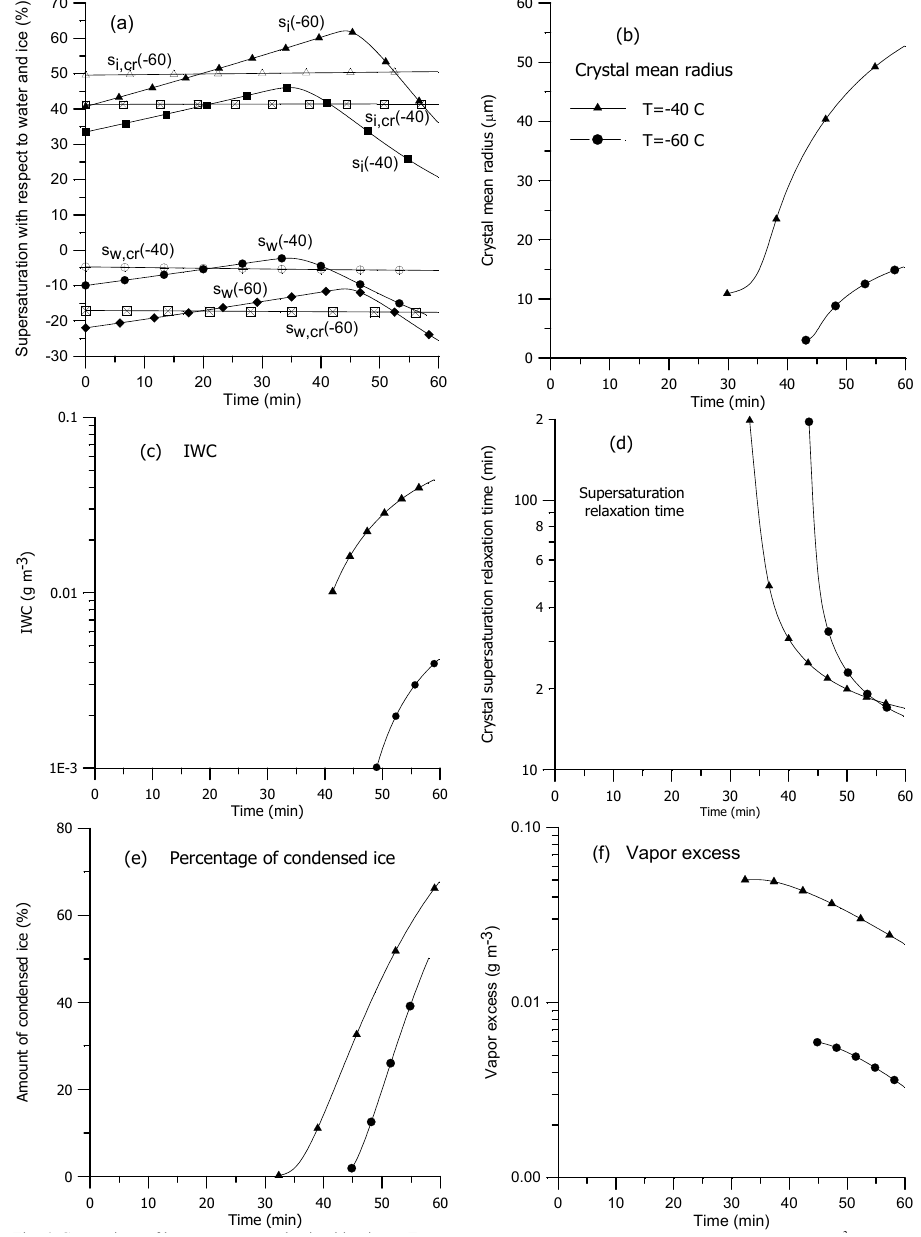
Fig. 6. Comparison of homogeneous nucleation kinetics at T = − 40 ◦ C and − 60 ◦ C (continuation). The other parameters are: RHW 0 ( − 40 ◦ C) = 90% and RHW 0 ( − 60 ◦ C) = 78%, p 0 = 340hPa, w = 4cms − 1 . (a) Supersaturations over water, s w , and ice, s i , %;